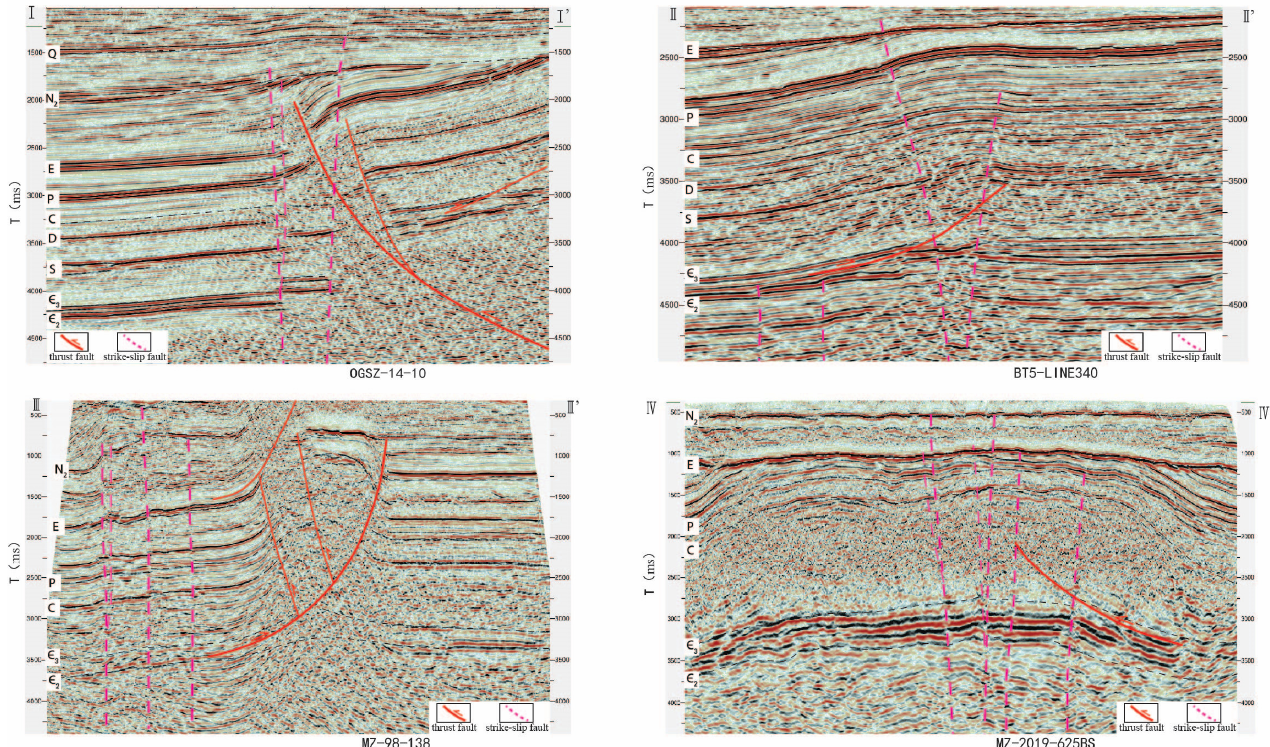
Figure 6. Characteristics of strike-slip fault profiles in Bachu Lift (The profile position is shown in Figure 3).